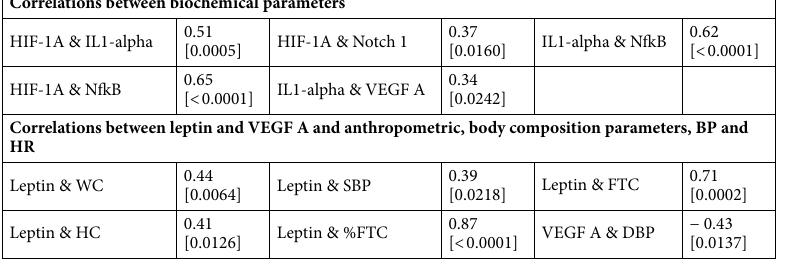
Group S after the